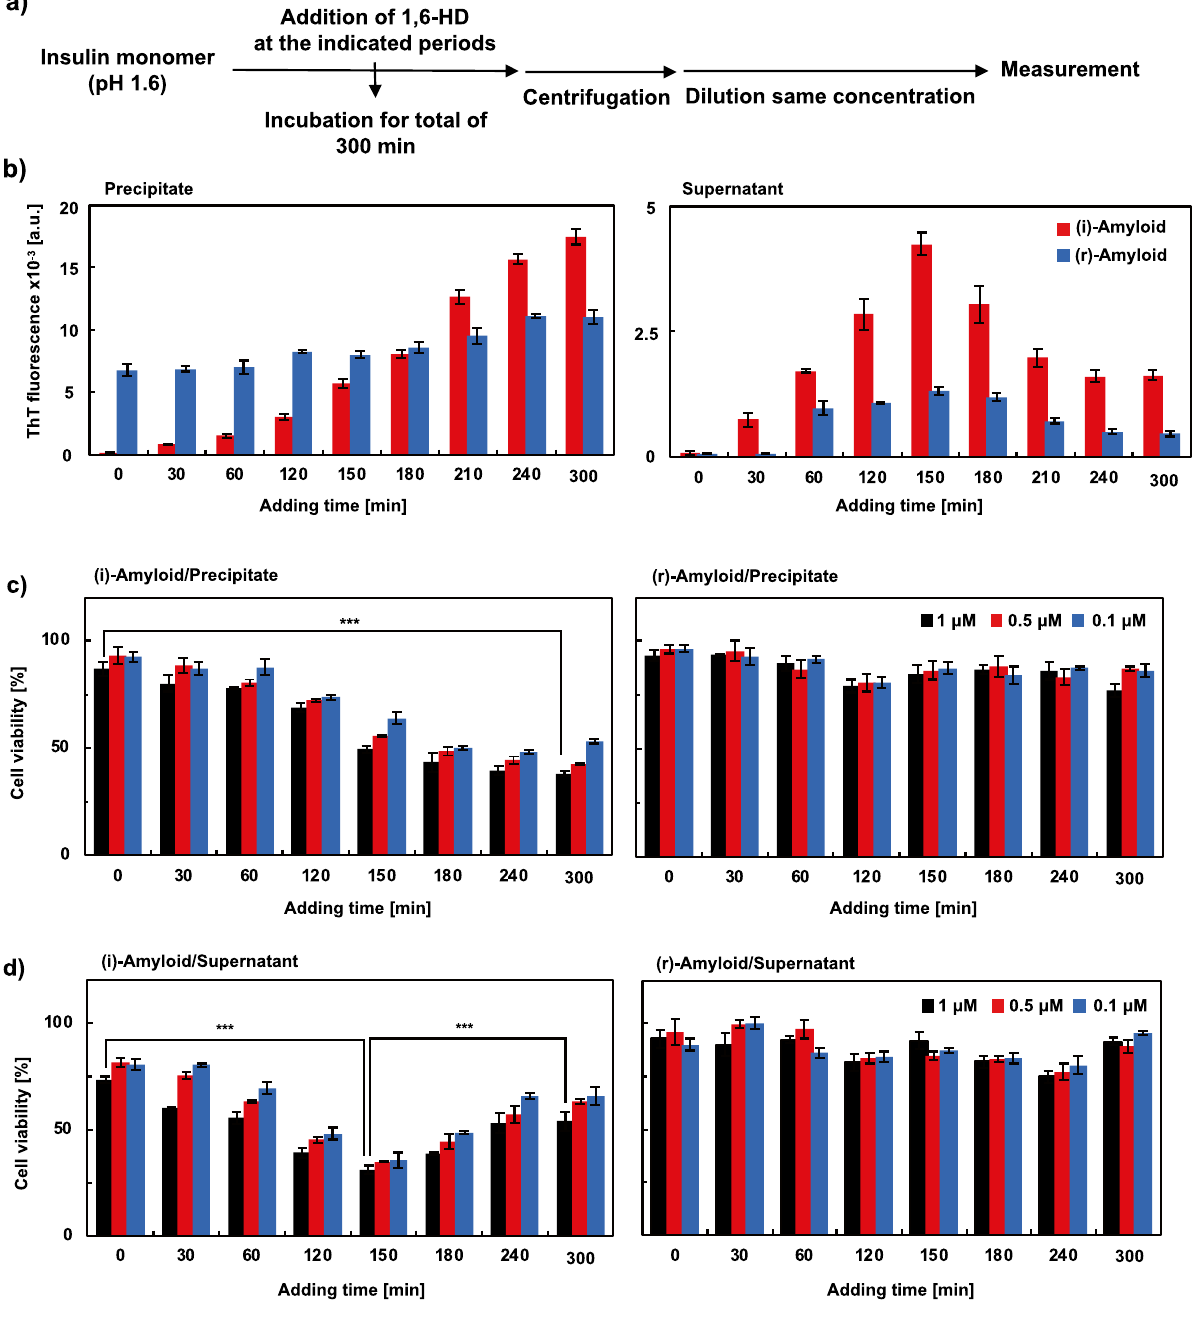
Figure 4. Evaluation of effect of 1,6-HD added on the formation process of the insulin amyloids. ( a ) Experimental scheme of ( b – d ). Samples in the precipitate (left) and the supernatant (right) are (i)-amyloids (red) and (r)-amyloids (blue) with 25% 1,6-HD added at the indicated time points and incubated for a total of 300 min. These samples were centrifuged at 15,000 rpm for 15 min and evaluated using ThT ( b ). Peak fluorescence values at 490 nm (ThT). Protein concentrations were adjusted to 5 µM. ( c and d ) Cytotoxicity of the samples in the precipitate ( c ) and the supernatant ( d ) of (i)-amyloids (left) and (r)-amyloids (right) with 25% 1,6-HD added at the indicated time points and incubated for a total of 300 min. These samples were centrifuged at 15,000 rpm for 15 min, and cytotoxicity was evaluated using the MTT assay against HeLa cells. All samples were quantified by BCA assay and were diluted to the same protein concentration: 1, 0.5, and 0.1 μM (black, red, and blue, respectively). The absorbance was normalized to 100% in PBS. ***P < 0.005 (two-tailed Student’s t